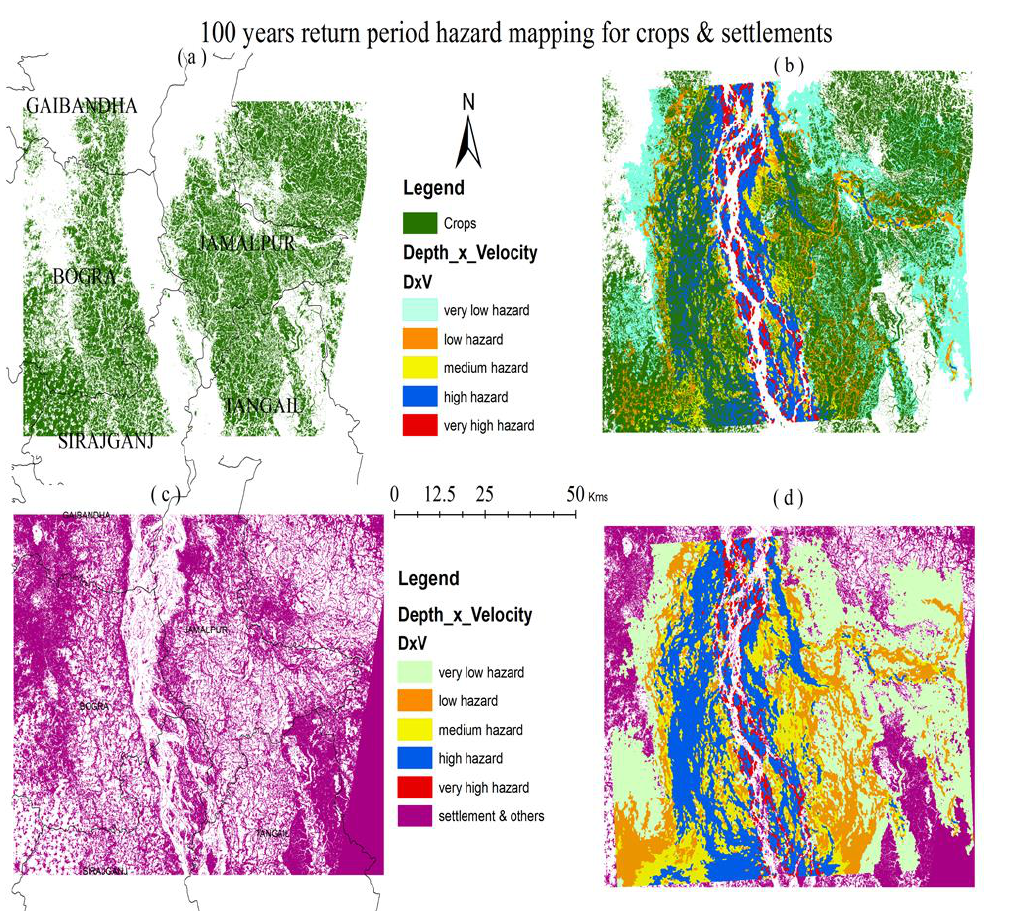
Fig. 10. Flood hazard mapping for settlements and